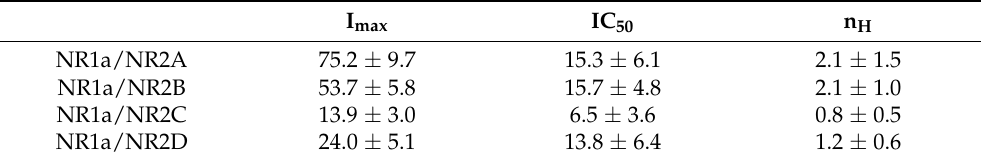
Table 1. The value of I max , IC 50 , and n H (Hill coefficient) of ergotamine for the glutamate-evoked current in each recombinant receptor. Values represent means ± S.E.M. ( n = 6–8/group). IC 50 , Hill’s coefficient; I max value as determined as described in Materials and methods.